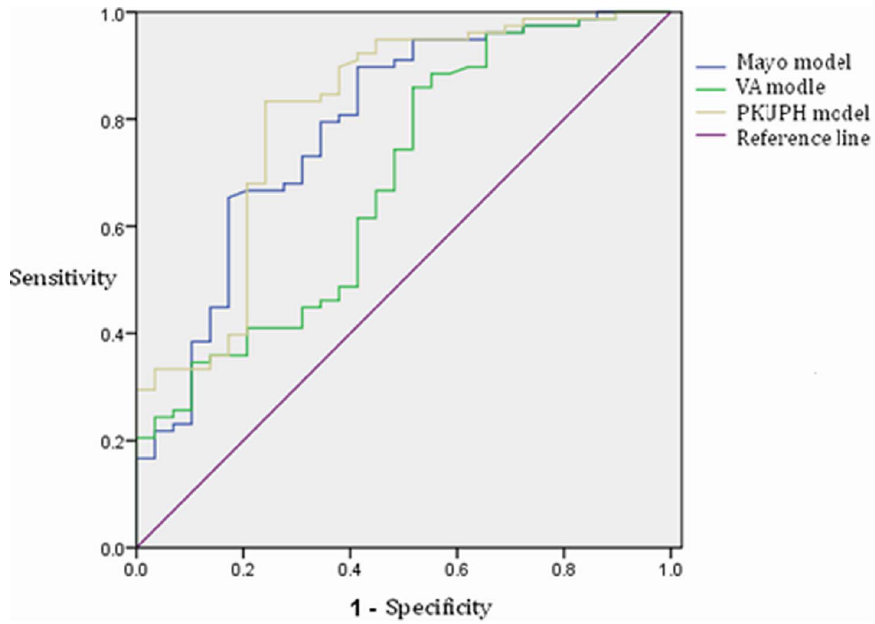
Figure 1. ROCs of different models.